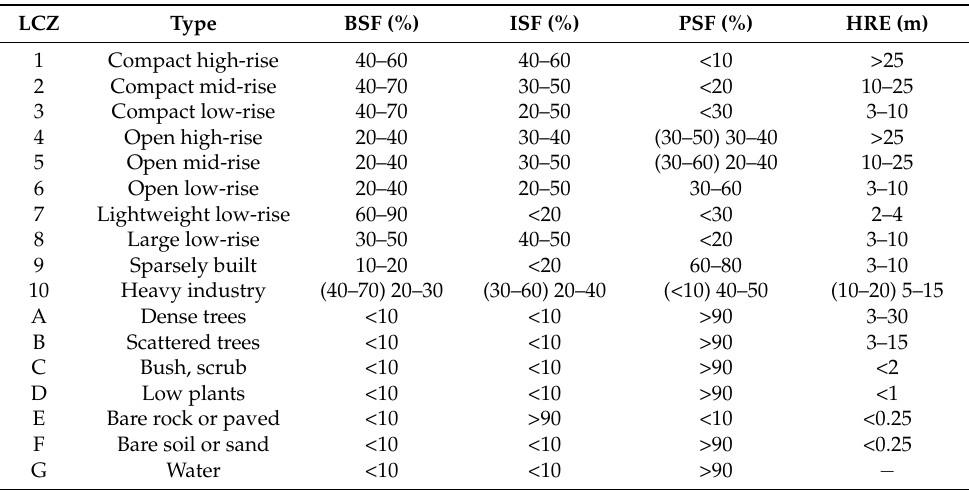
Table 2. Selected surface cover properties of the local climate zones valid for the central European region ([4], modified); BSF, building surface fraction; ISF, impervious surface fraction; PSF, pervious surface fraction; HRE, height of roughness